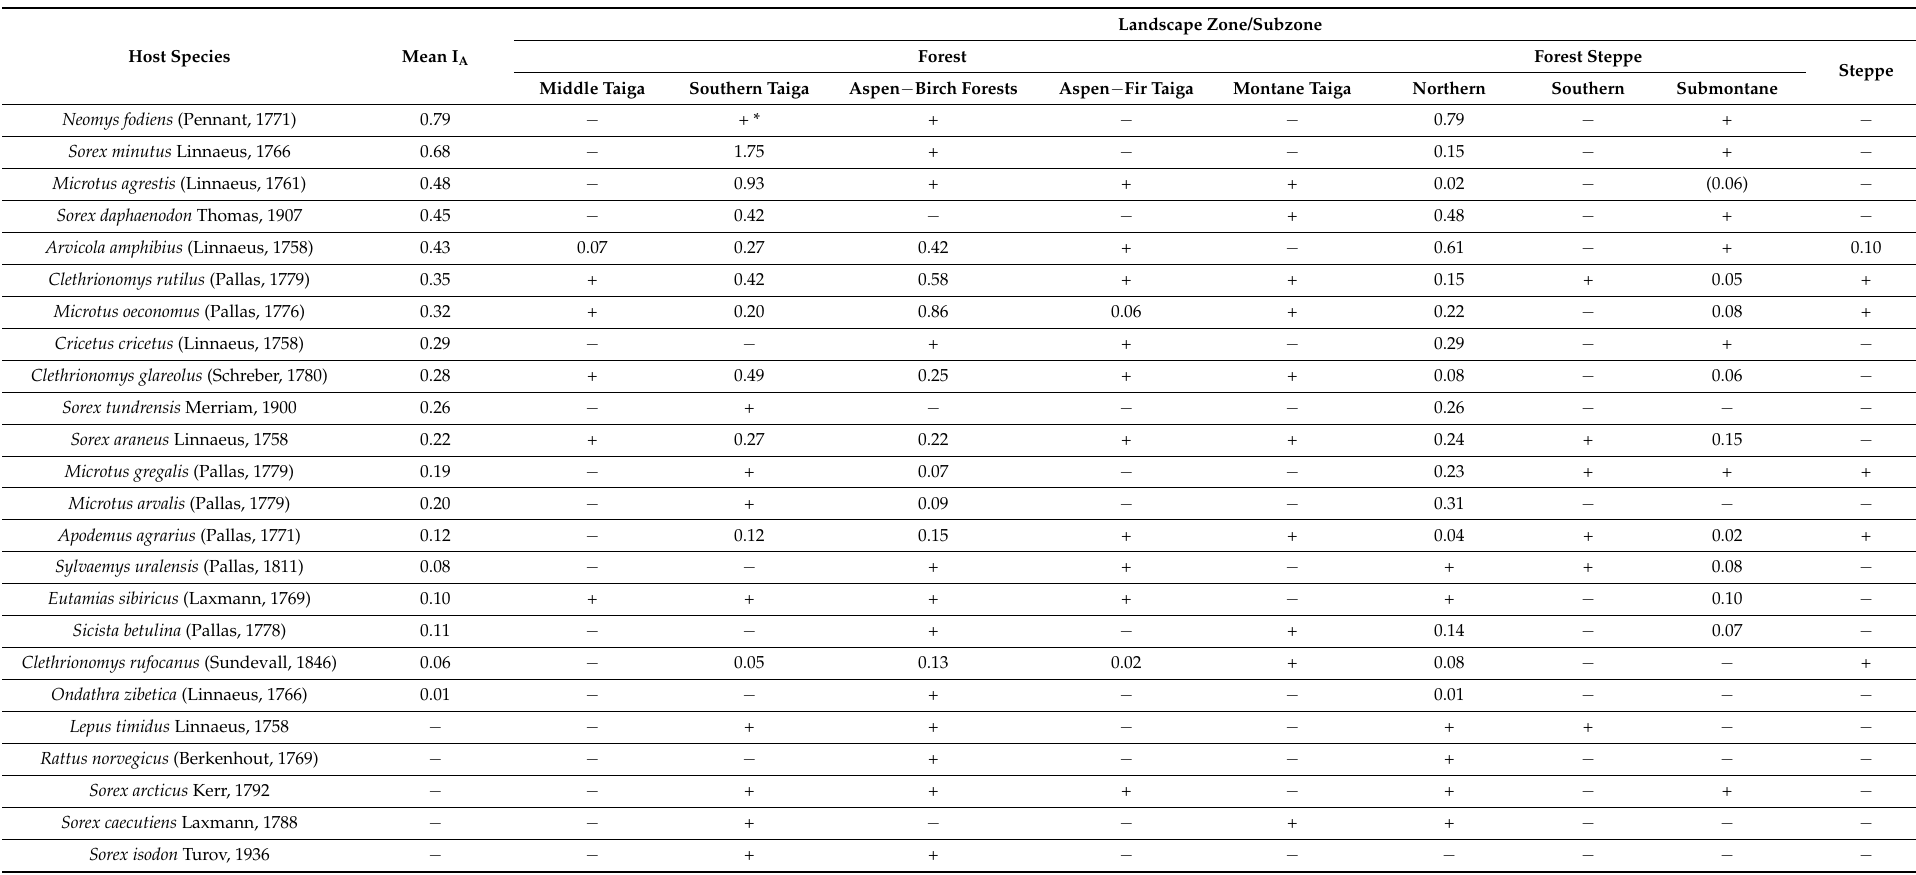
Table 1. Mammal hosts of Ixodes apronophorus in West Siberia and their presence/absence in different landscape zones and subzones, with the values of their respective I A . Host species are arranged according to their mean I A values (in descending